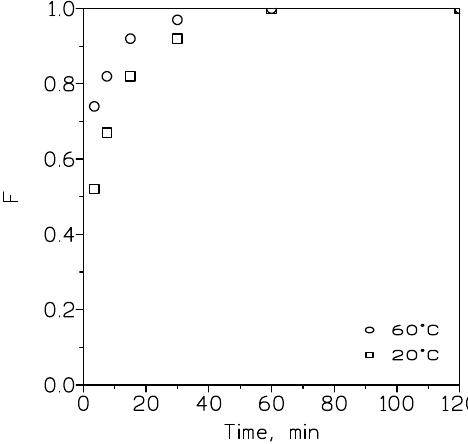
Figure 5. Influence of temperature on gold(III) adsorption. The F values were calculated as in Equation (3).